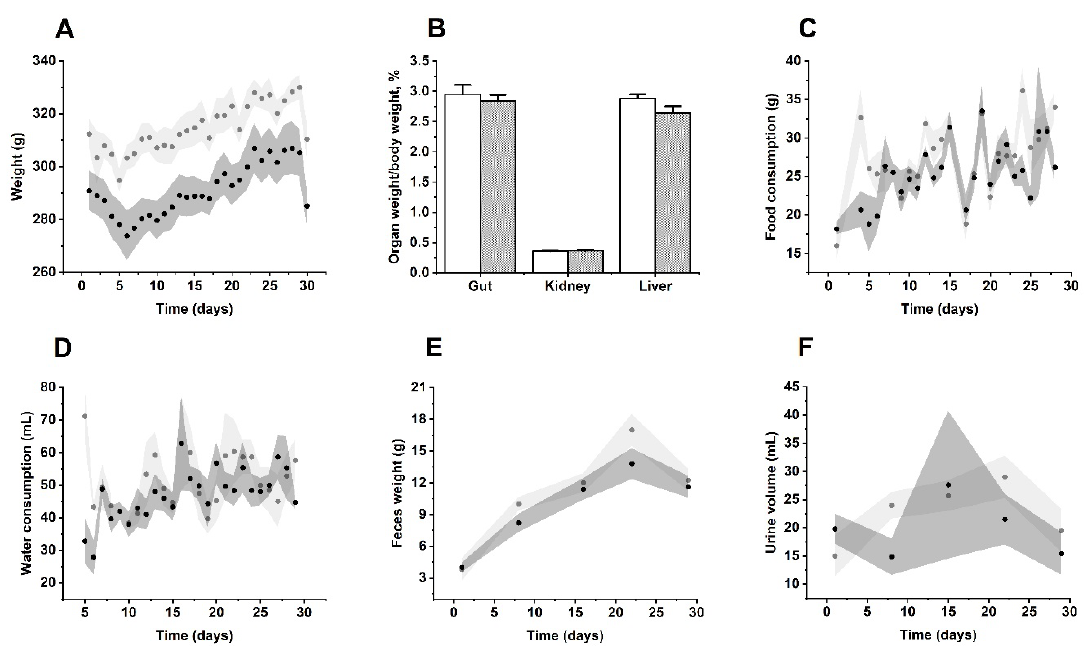
Figure 2. Effects of MIX–160 on the ( a ) body weight, ( b ) tissue–mass percentage, ( c ) food consump- tion, ( d ) water consumption, ( e ) excreted feces and ( f ) urine in repeated dose 28–day oral toxicity evaluations. The control group is represented in light gray or white, and MIX–160 is represented in dark gray.